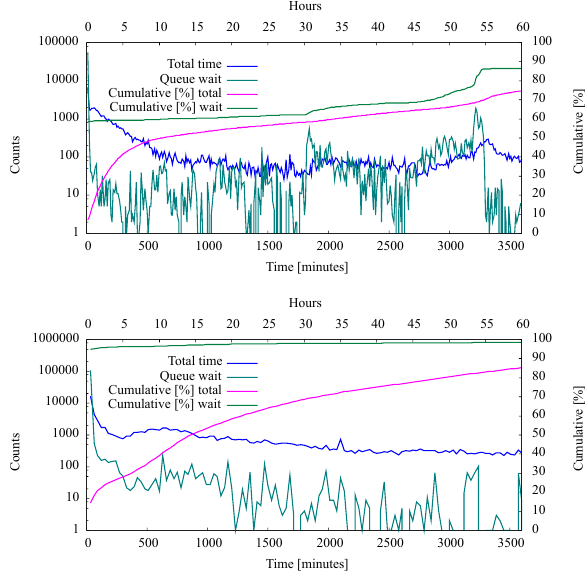
Figure 9: Distribution of the total processing time from the WU sub- mission to the result acquisition and the waiting time component shown for the 10 5 turns run (upper panel) and 10 6 turns run (lower panel). The cumulative distribution is plotted against the right lin- ear axis, showing the fraction of acquired results. Note the log-scale for the histogram entries on the left axis.